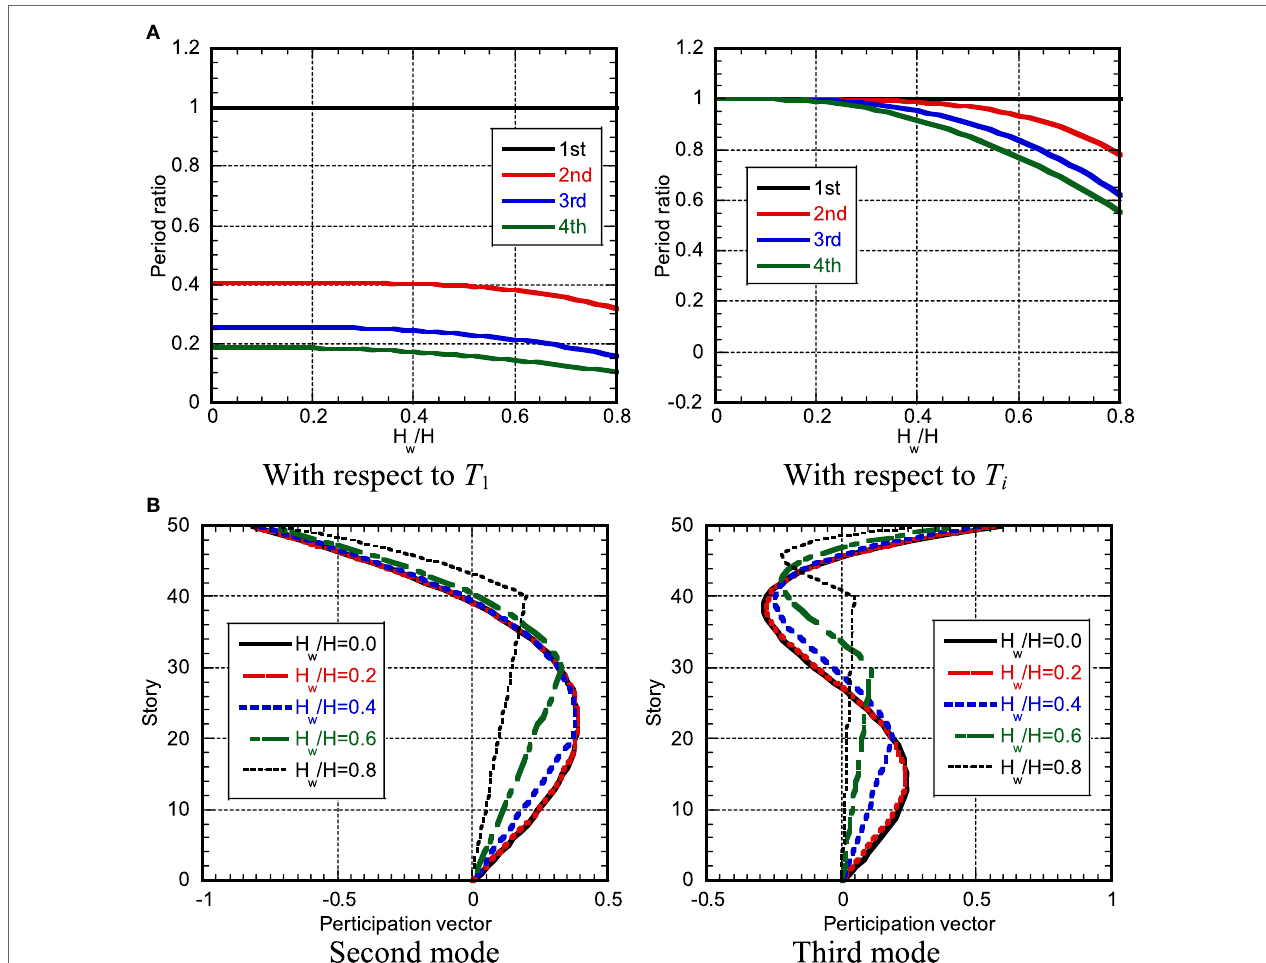
FIGURE 2 | Change of natural period and participation vector to wall height: (A) change of natural period and (B) change of participation vector.